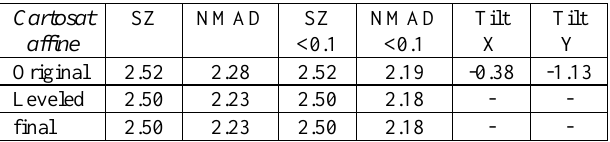
Table 12: Accuracy figures and DSM-tilt over full range [m], Cartosat-1 against reference DSM; <0.1 = for slope below 0.1;